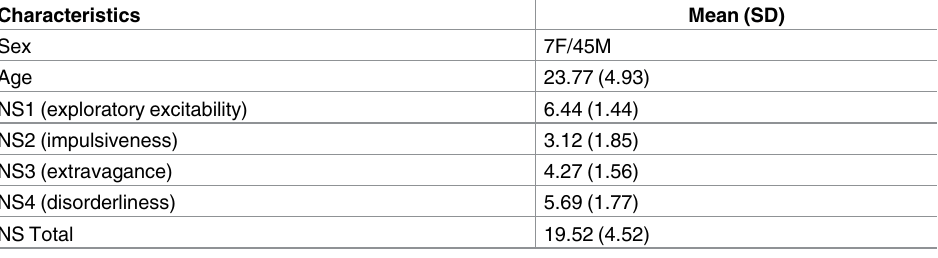
Table 4. Participant Characteristics.